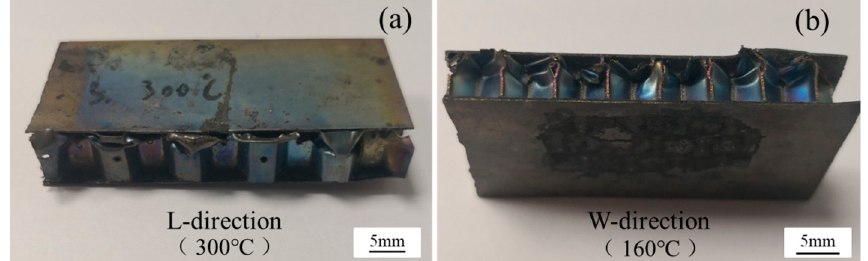
Figure 7. Damage morphology of vented honeycomb sandwich panels subjected to flatwise. Materials 2020 , 13 , x FOR PEER REVIEW